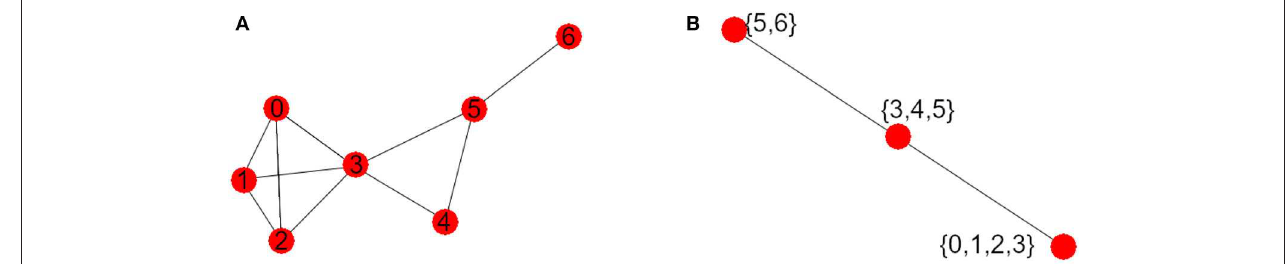
Frontiers in Bioengineering and Biotechnology | www.frontiersin.org